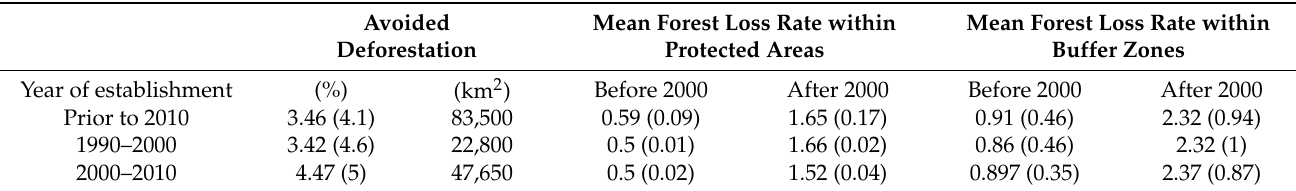
Table 1. Estimates of avoided deforestation by all PAs (established prior to 2010) by year of establishment to show the difference in effectiveness. Newer PAs established during the 2000s show more effectiveness compared to PAs established prior to 2000, as well as all PAs. Numbers in parenthesis represent estimates using median forest loss rate. Avoided Mean Forest Loss Rate within Mean Forest Loss Rate within Deforestation Protected Areas Buffer Zones Before 2000 After 2000 Before 2000 After